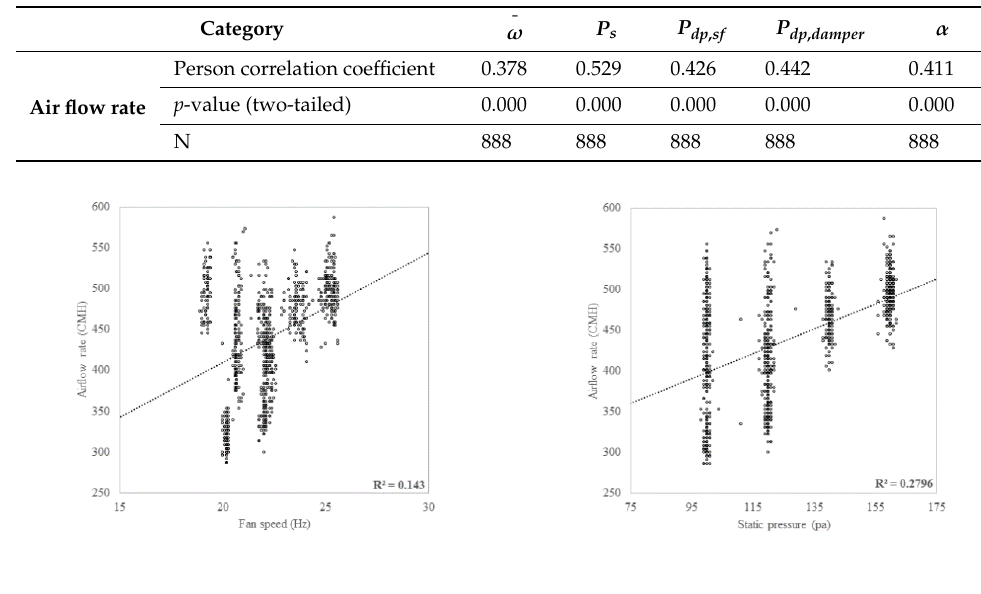
Table 4. Correlation analysis result.